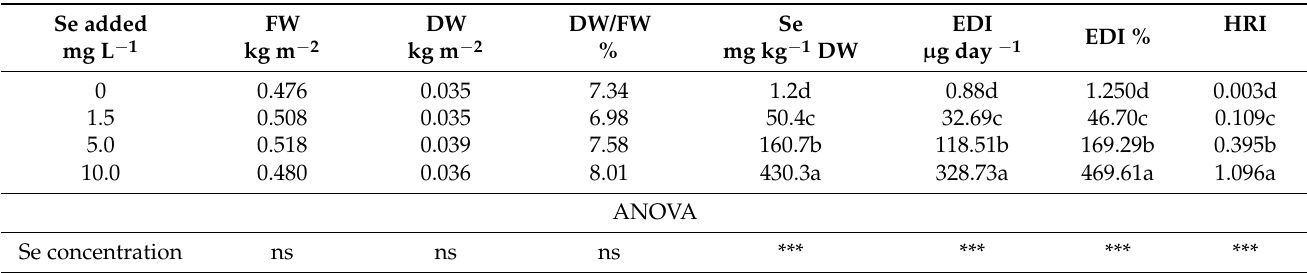
Means (n = 3) flanked by the same letter are not statistically different for p = 0.05 after Duncan’s test. Significance level: *** p ≤ 0.001; ns = not